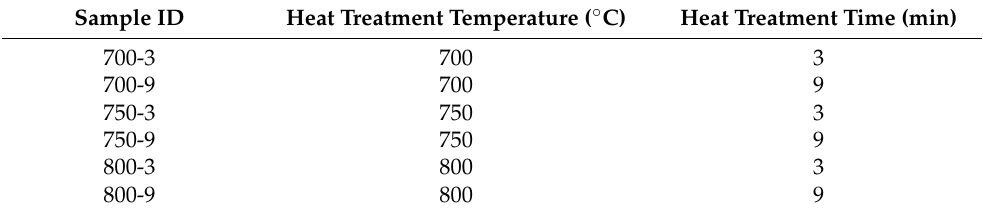
Table 1. The heat treatment temperatures and times of the fibers.